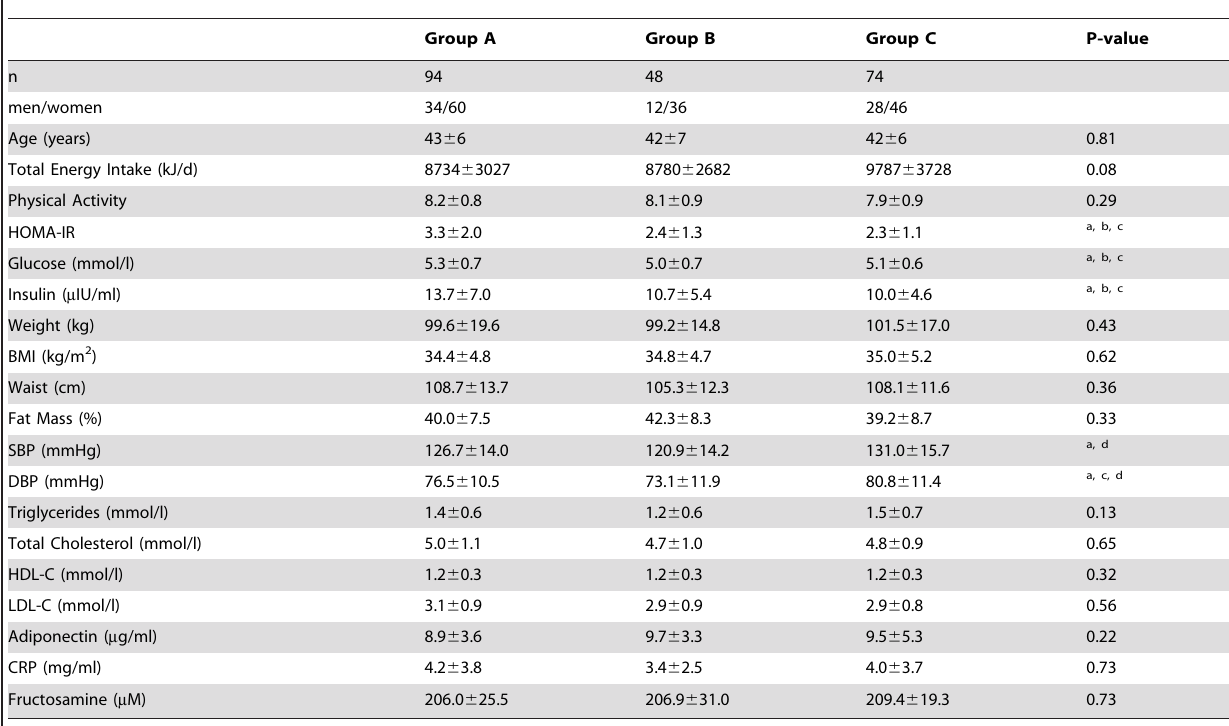
Table 1. Bioclinical parameters of the 3 groups at